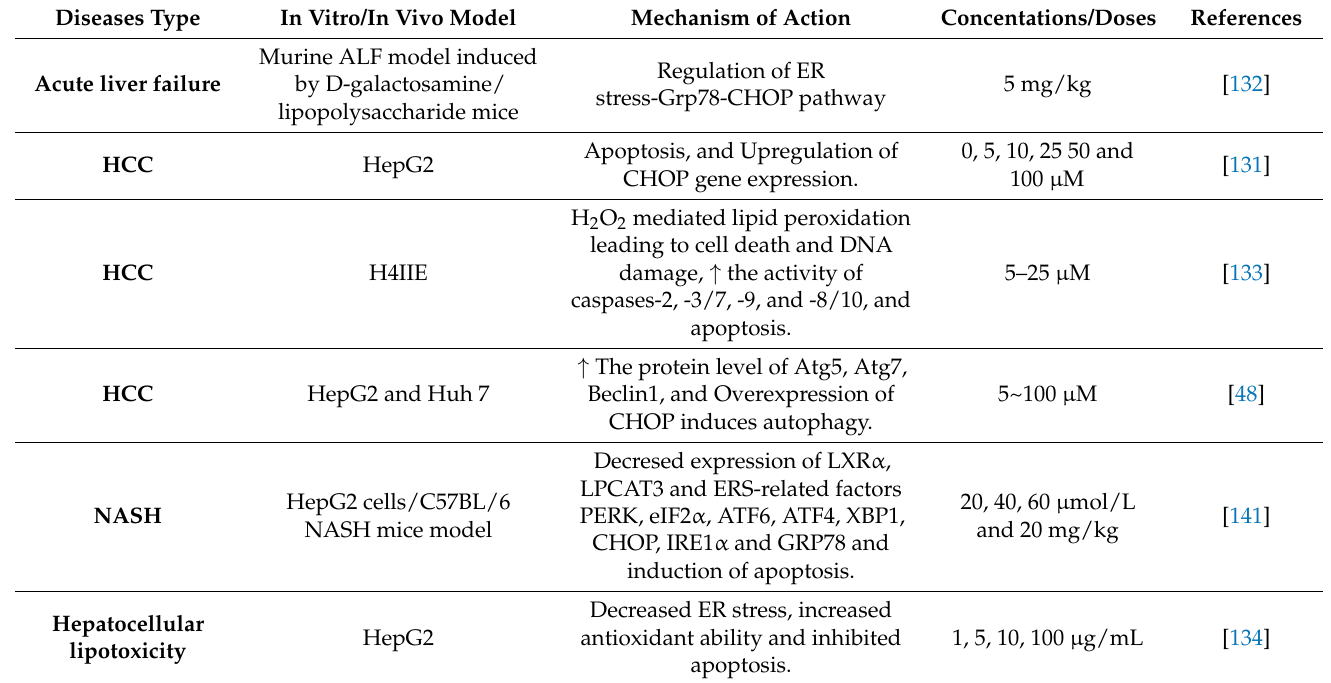
Table 3. Role of kaempferol in the induction of cell death (apoptosis/autophagy) through ER stress and oxidative stress pathways